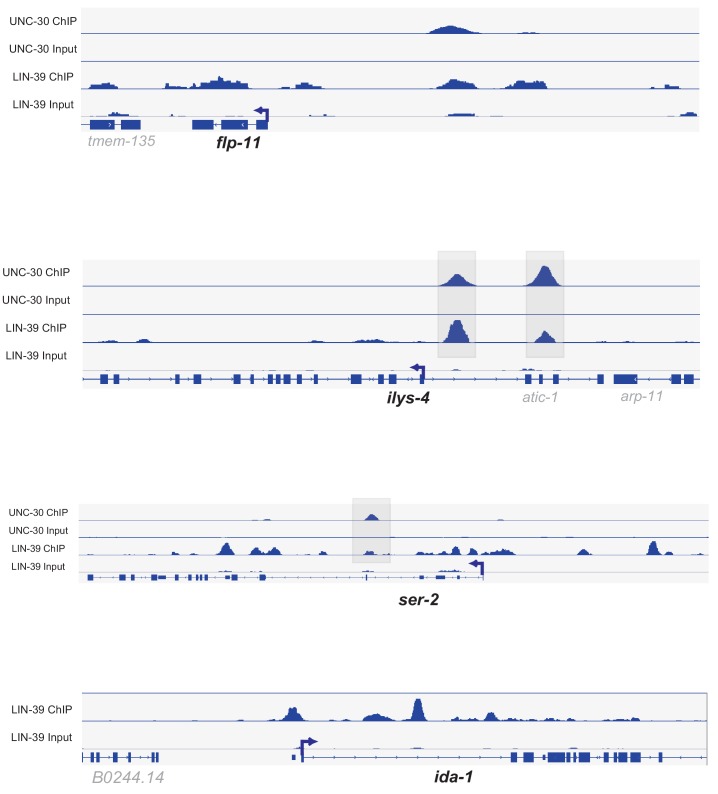
LIN-39 binds directly to the cis-regulatory region of VD and VC terminal identity genes.ChIP-Seq tracks for UNC-30 and LIN-39 are shown for the VD-expressed genes flp-11, ilys-4, and ser-2. ChIP-Seq tracks for LIN-39 are shown for the VC-specific terminal identity gene ida-1. ChIP-Seq data for LIN-39 were generated through the modENCODE project (Boyle et al., 2014) and ChIP-Seq data for UNC-30 were previously generated (Yu et al., 2017). ChIP-seq data were visualized using Integrative Genomics Viewer (Siponen et al., 2010) (Thorvaldsdóttir et al., 2013) and snapshots of ChIP-Seq tracks were generated.